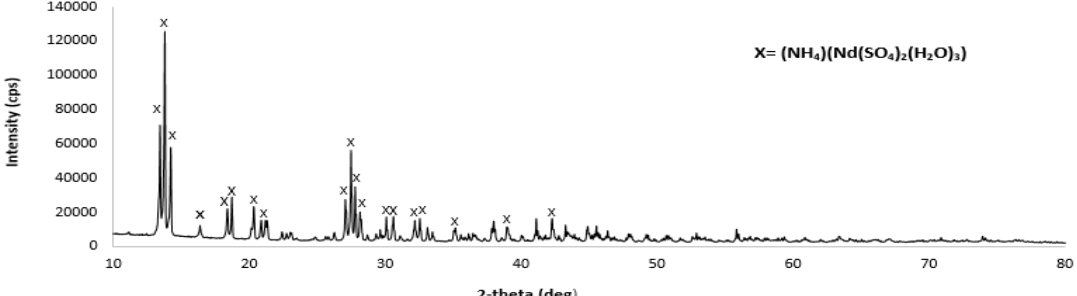
Figure 4. Crystal phases in the REE rich precipitate after adding NH 4 OH.